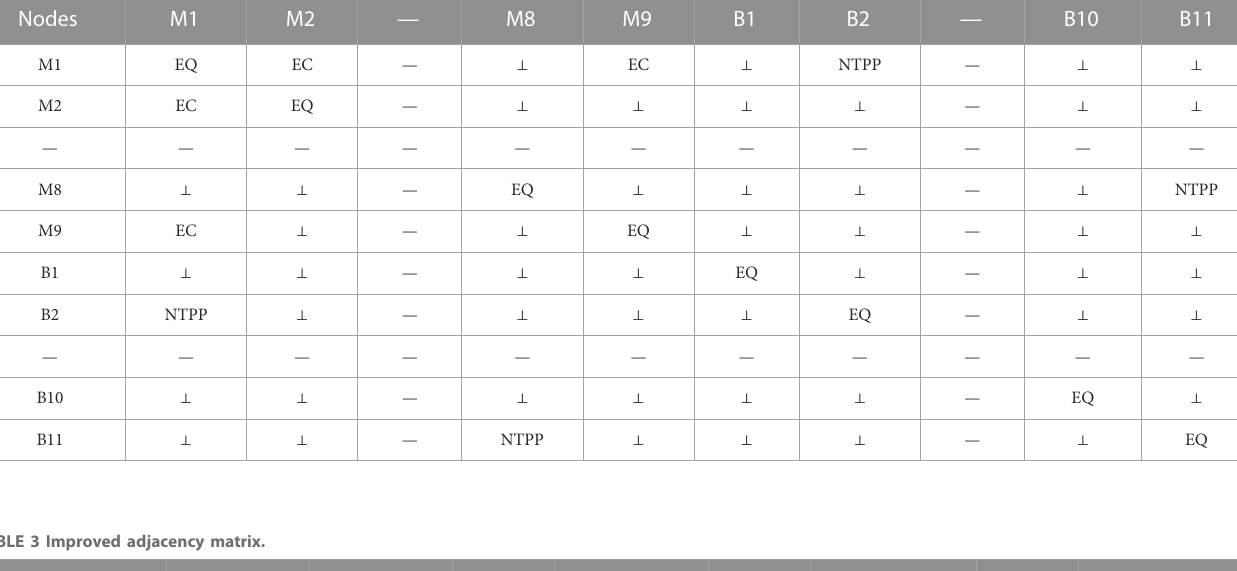
TABLE 2 The adjacency matrix of space relations of vector maps in Figure 6. Nodes